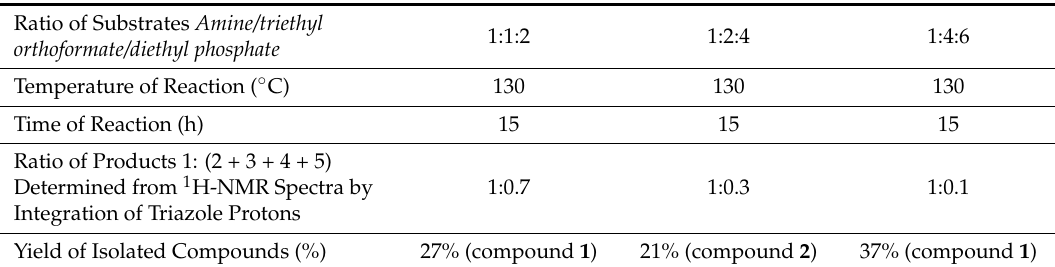
Table 1. Yields and ratios of the products of the reaction between 3-amino-1,2,4-triazole, triethyl orthoformate and diethyl phosphite.